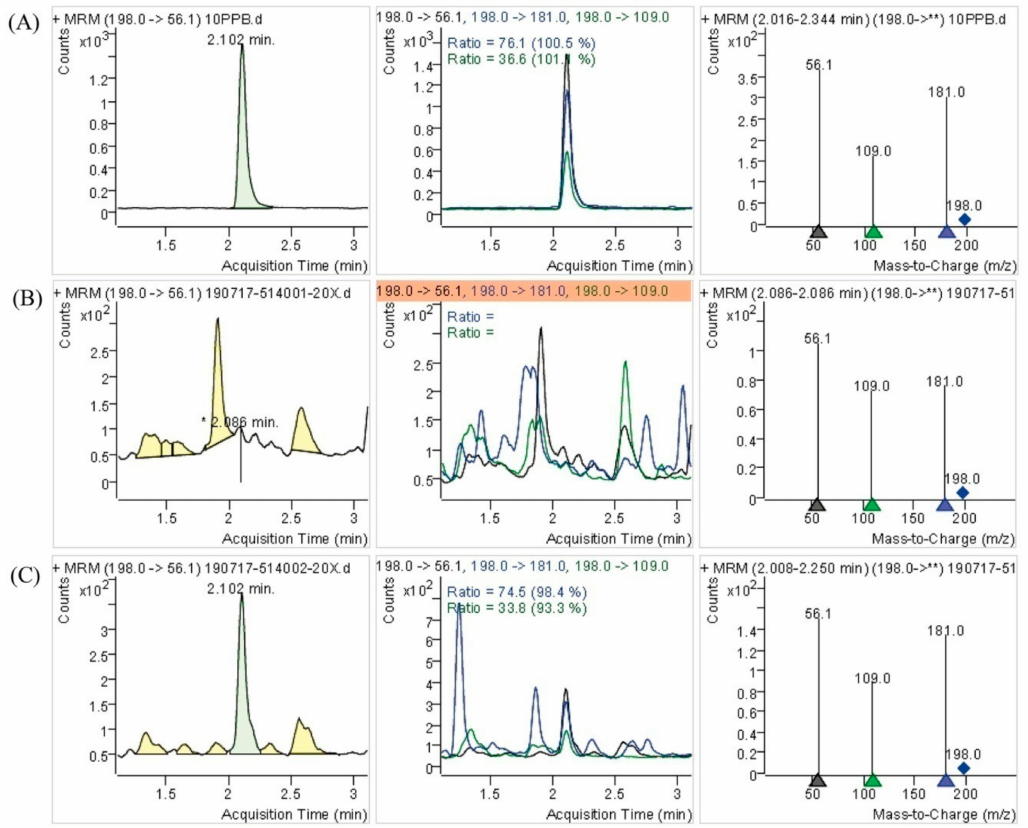
Figure 4. Determination of l -selenomethionine (Se-Met) of DB-yeast and Se-enriched DB-yeast by LC–MS. ( A ) Se-Met standard substance (10 mg / L). ( B ) DB-yeast. ( C ) Se-enriched